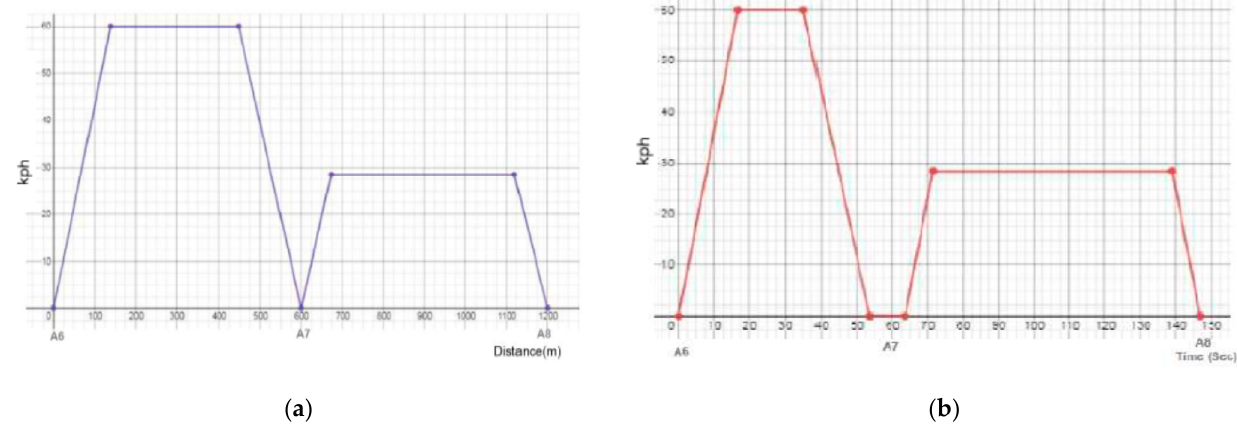
Figure 5. A schematic diagram represents the train movement from A6 to A8 directly with dynamic speed variability. ( a ) Distance. ( b ) Time.